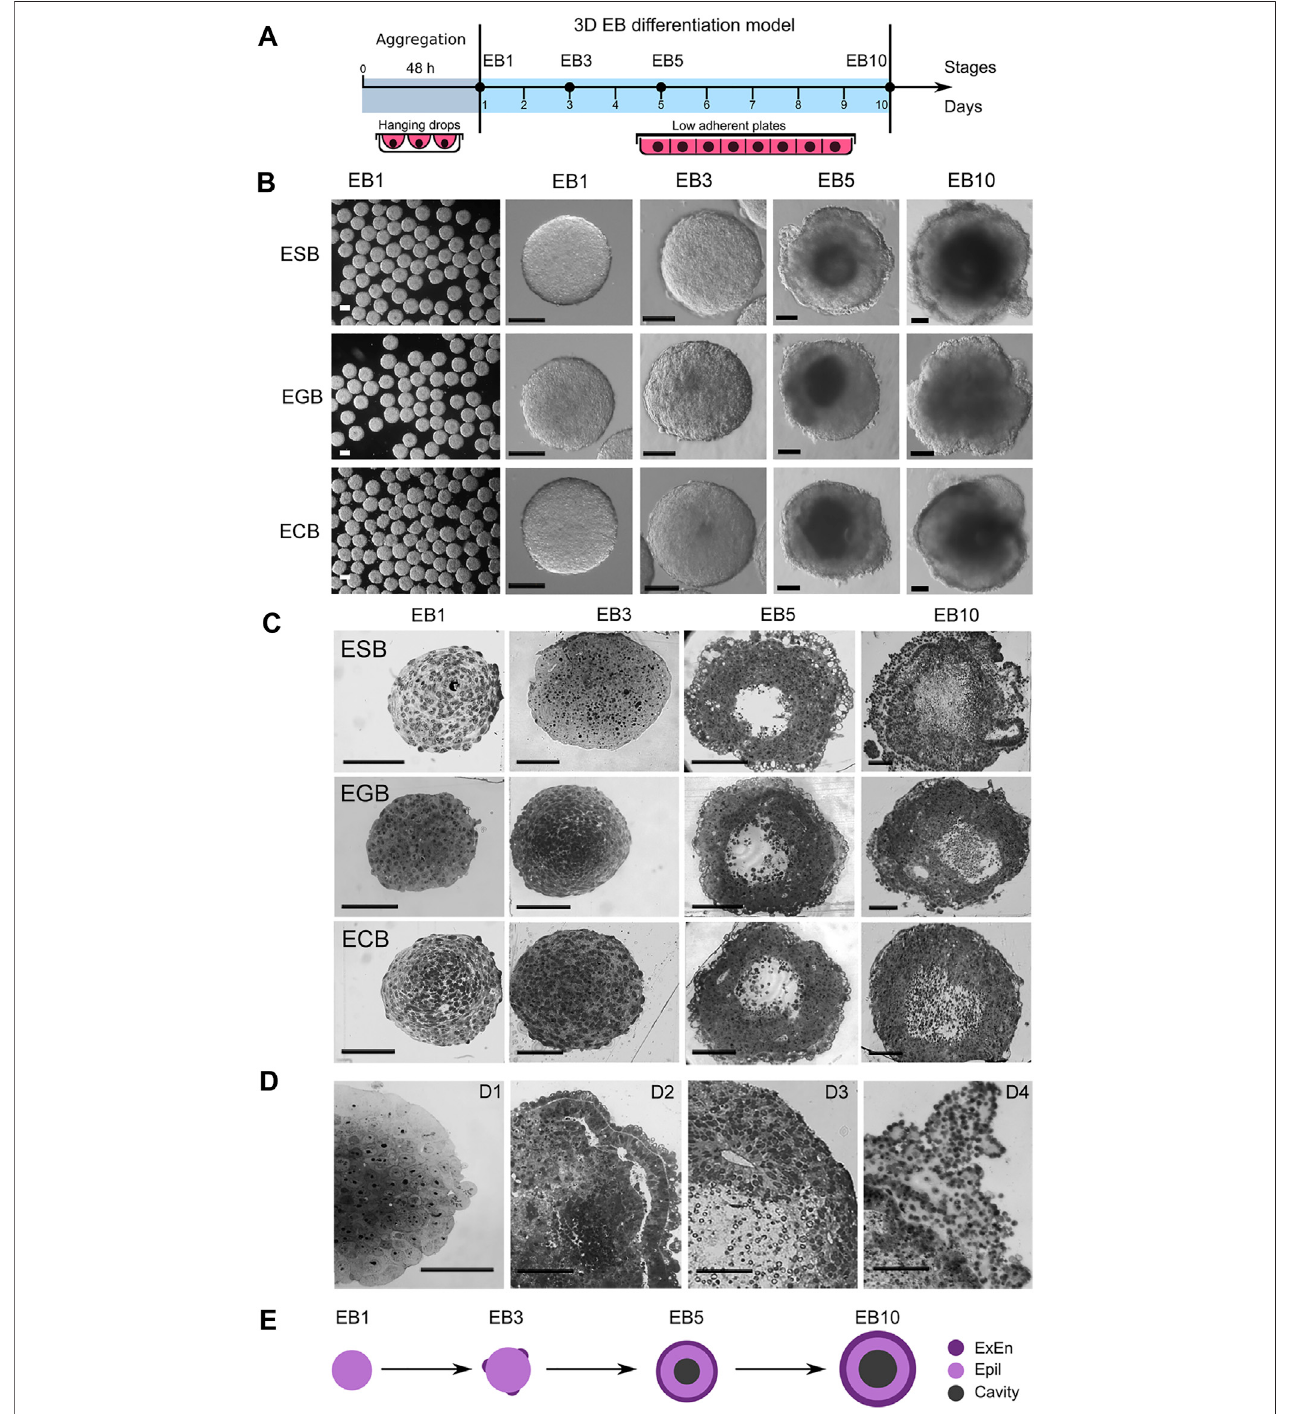
FIGURE 1 | 3D EB differentiation model: architectures and dynamics of ESBs, EGBs, and ECBs. (A) Schematic timeline for 3D EB differentiation model: EB formationinhangingdropsanddifferentiationinsuspensionculturesystemfor10 daysatEB1,EB3,EB5,andEB10stages. (B) Representativeimagesofdifferentiating ESB, EGBs, and ECBs with similar morphological patterns at the corresponding stages. (C,D) Histological sections of differentiating ESB, EGBs, and ECBs. (C) Similar spatiotemporal differentiation dynamics of ESB, EGBs, and ECBs and the formation of the EB archetype containing three morphologically distinct patterns. [(D), D1 – D4] MorphogeneticeventsduringEBdifferentiation:compaction [(D),D1] epithelizationofextraembryonicendoderm(ExEn)andepiblast-like(Epi-l)cellpatternsand delamination of inner cell layers [(D),D2] formation of internal cavities via the delamination and apoptosis [(D),D3] , and hypertrophy of ExEn immersed in the thick extracellularmatrix [(D),D4] . (E) Schematictimeline forforming oftheEBarchetype withthree distinct patterns: ExEnand Epi-lcellular patternsand inner cavity. (B,C,D) Scale bars: 100 μ m.